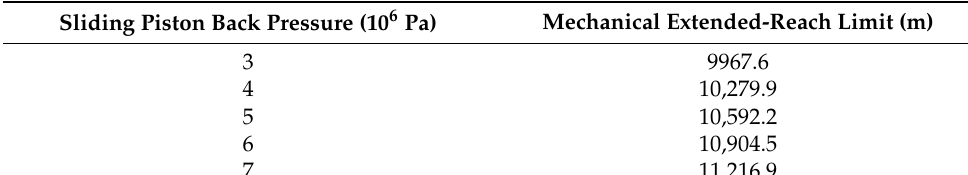
Table 5. Mechanical extended-reach limits with different sliding piston back pressures.